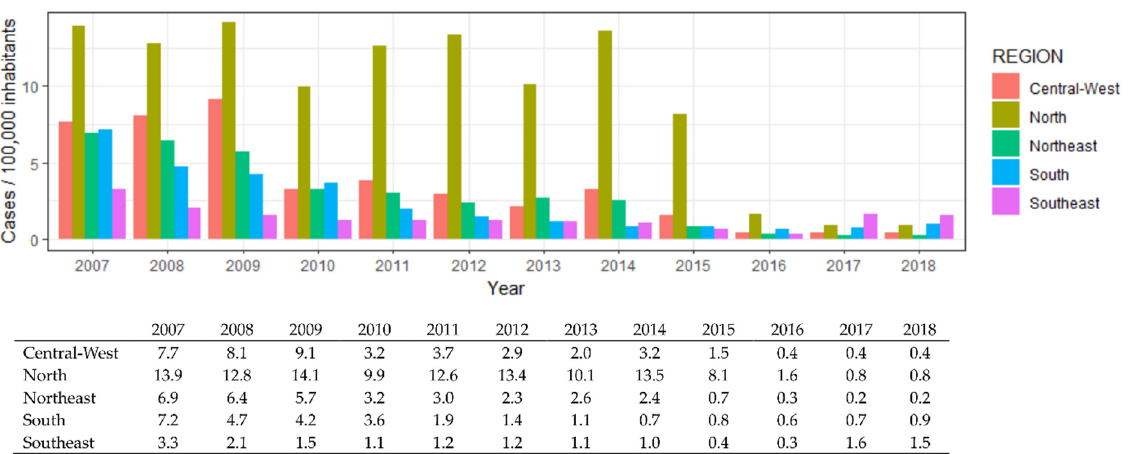
Figure 1. Hepatitis A cases per 100,000 inhabitants by year and Brazilian region with supporting data (cases/100,000 inhabitants by region and year).